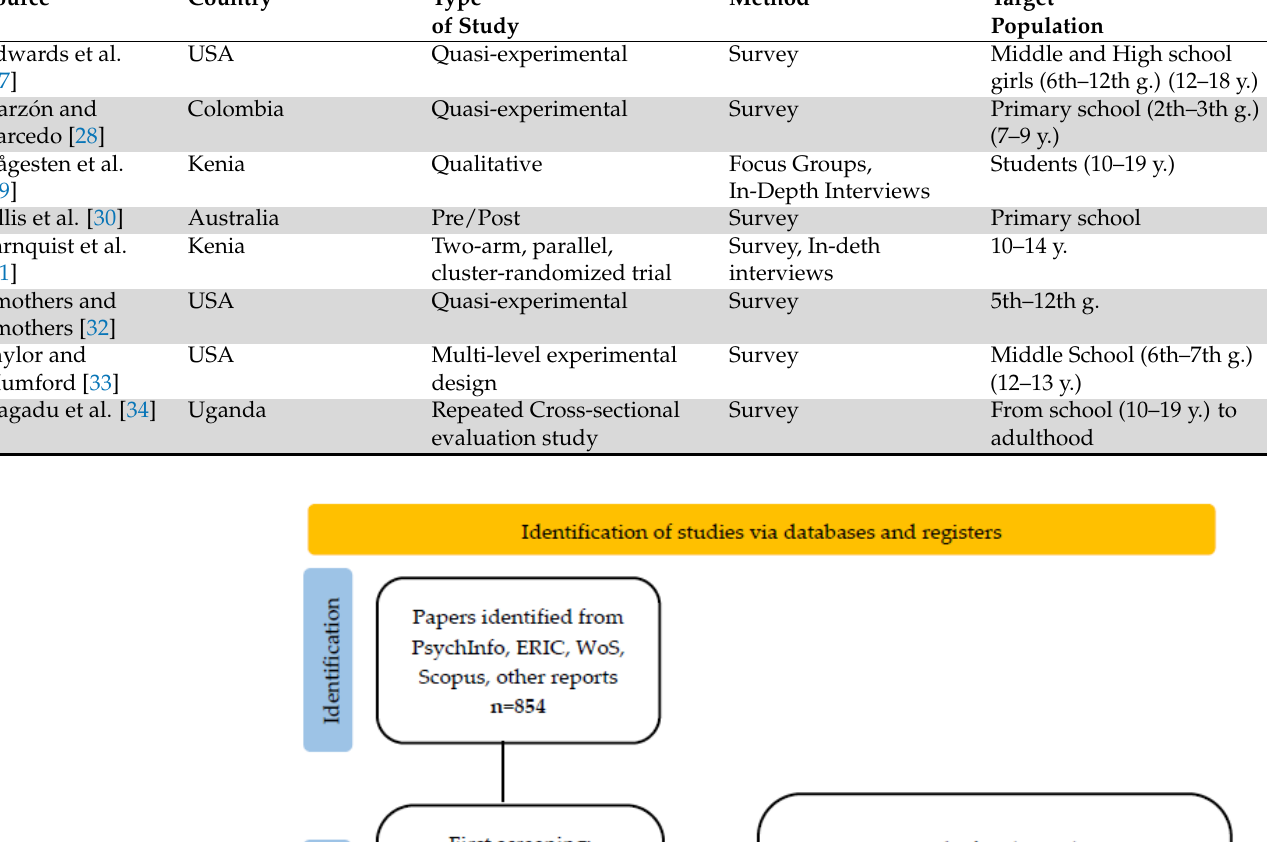
Table 2. Overview of the studies’ main characteristics.